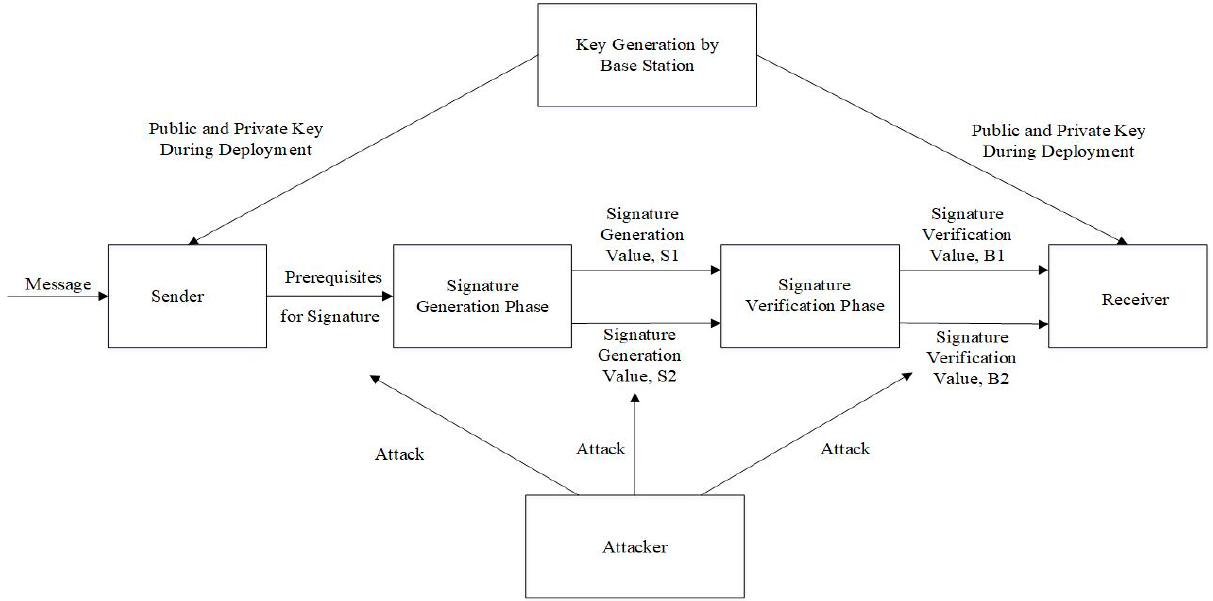
Figure 2. Signature generation and verification process.